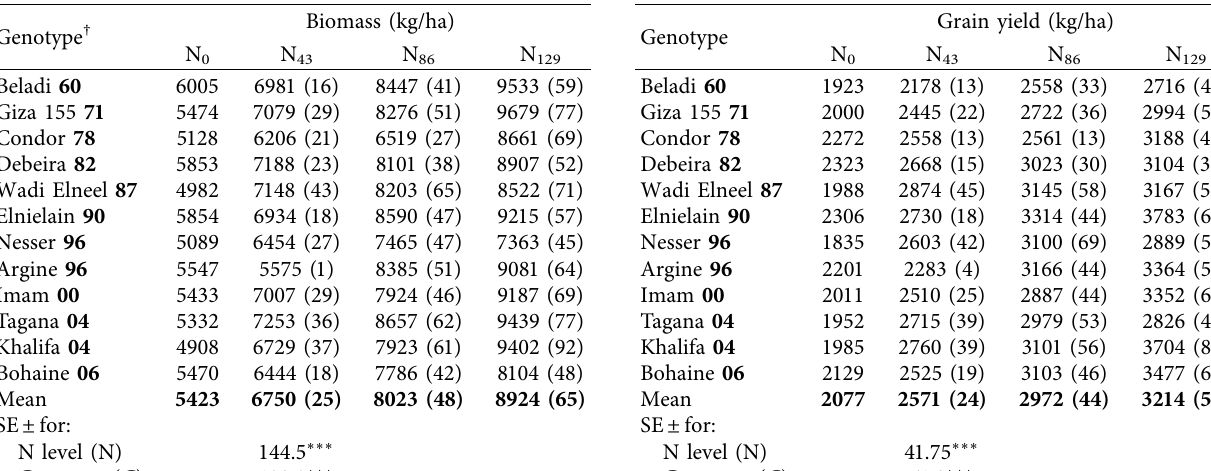
Figure 1: Weekly maximum and minimum temperature at Gezira Research Station during two cropping seasons (2006/07 and 2007/08) together with a 30-year average (LTA) temperature (1980–2010). Table 1: Mean biomass (kg/ha) of 12 bread wheat genotypes grown for two seasons under four N levels at Gezira Research Station Farm, Wad Medani, Sudan.